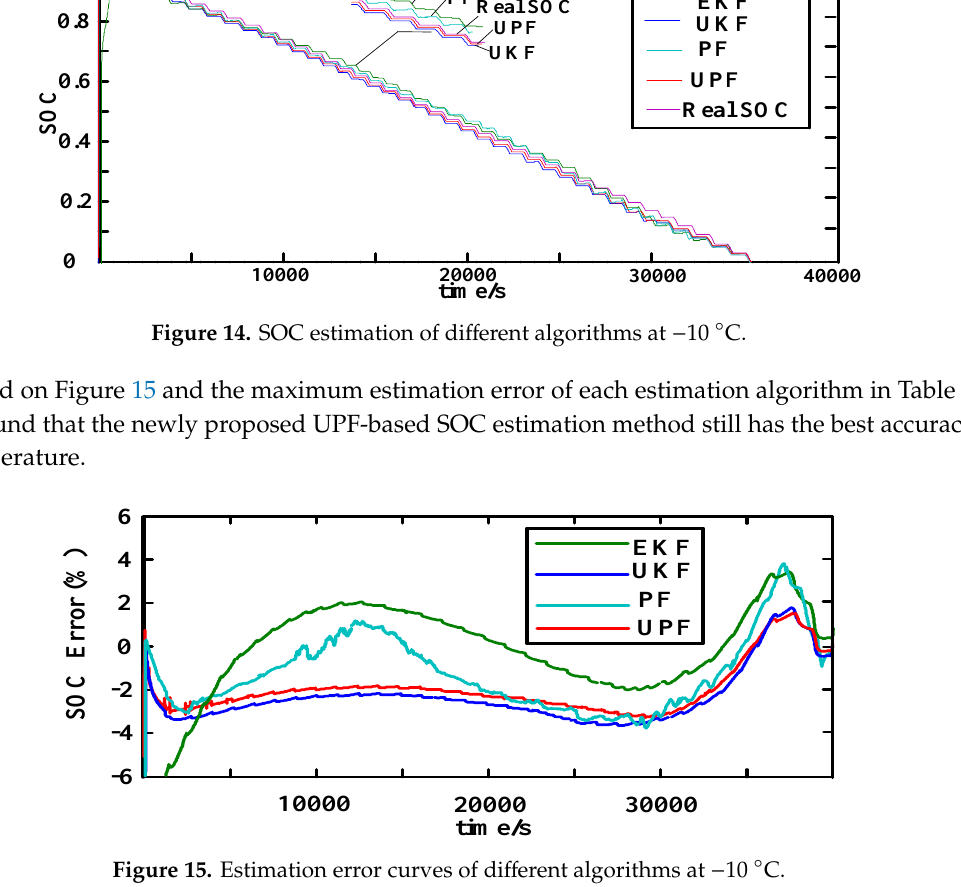
Table 8. Maximum Estimation Error of Different Algorithms at −10 °C.